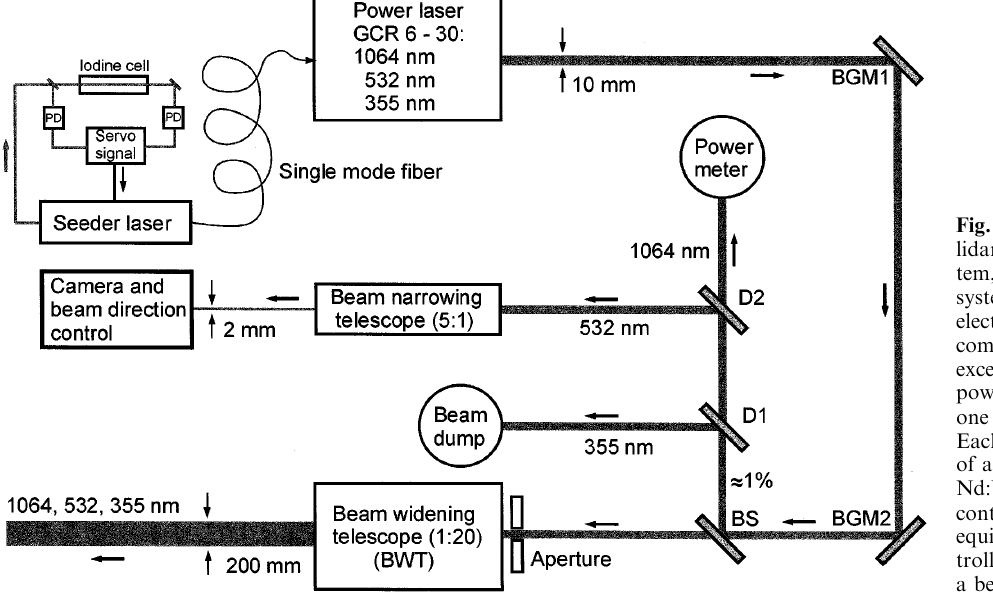
Fig. 2. Main components of the lidar transmitter: the seeder sys- tem, two identical power laser systems, the synchronization electronics, and three control computers. All the equipment, except the voltage supplies for the power lasers, is located within one temperature stabilized room. Each power laser system consists of an optical table, pulsed Nd:YAG laser, the two piezo- controlled mirrors BGM 1 and 2, equipment for guiding and con- trolling the laser beam laser, and a beam